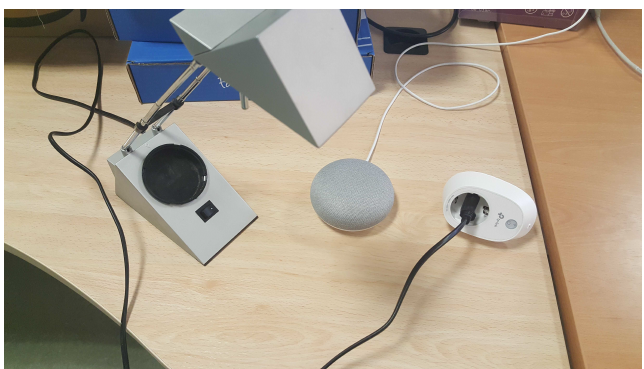
Figure 6. Image of the setup arranged in the laboratory to carry out task #1 of the evaluation experiment (household appliance